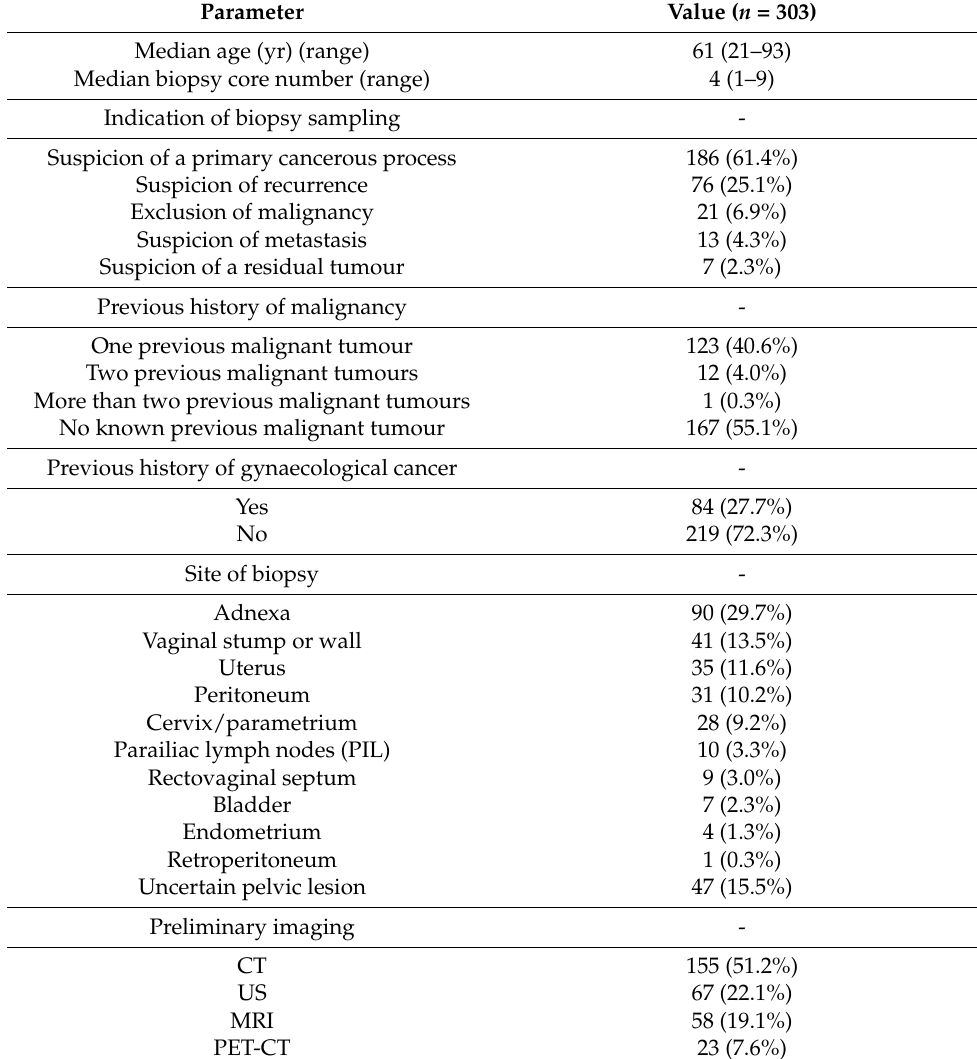
Table 1. Characteristics of the patients included in the